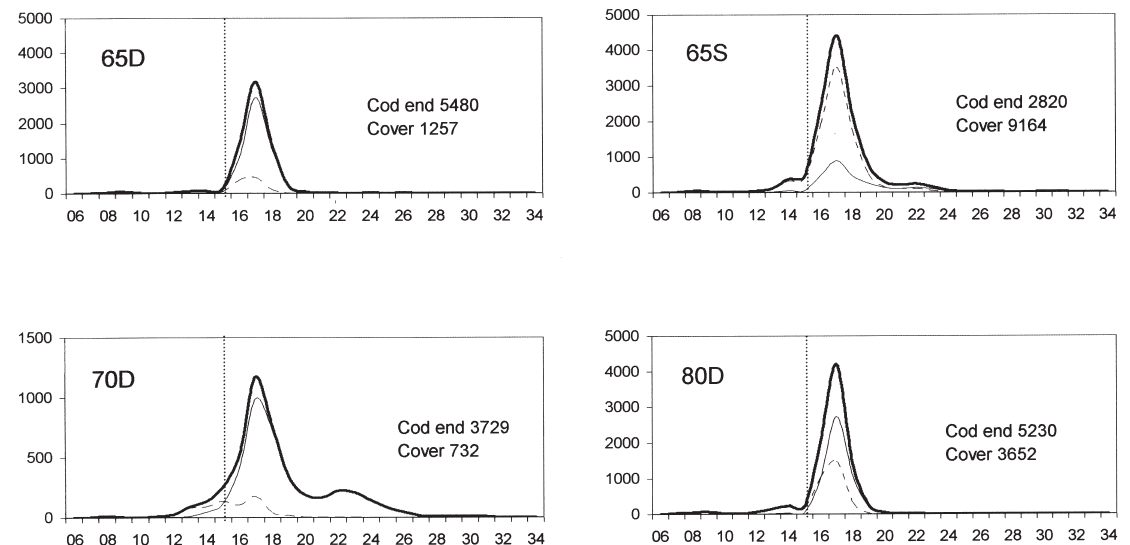
Fig. 3. – Trachurus trachurus (horse mackerel). Size structure of the populations that entered the diamond cod ends (D) and the square mesh cod end (S). X-axis – length (cm). Y-axis – numbers. Thin line corresponds to length frequency in cod end, dashed line in cover and thick line to total numbers. Dotted vertical line indicates the minimum landing size MLS.